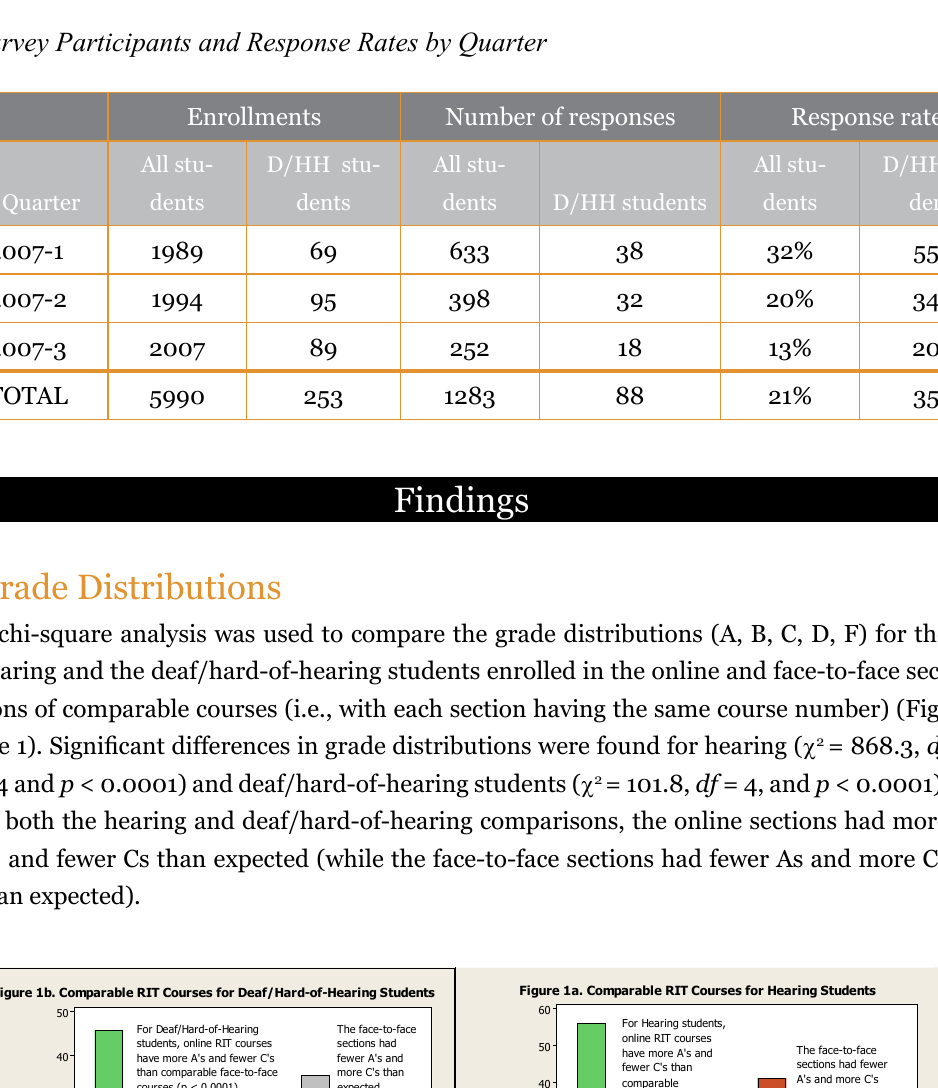
0.0001).face-to-face (p <